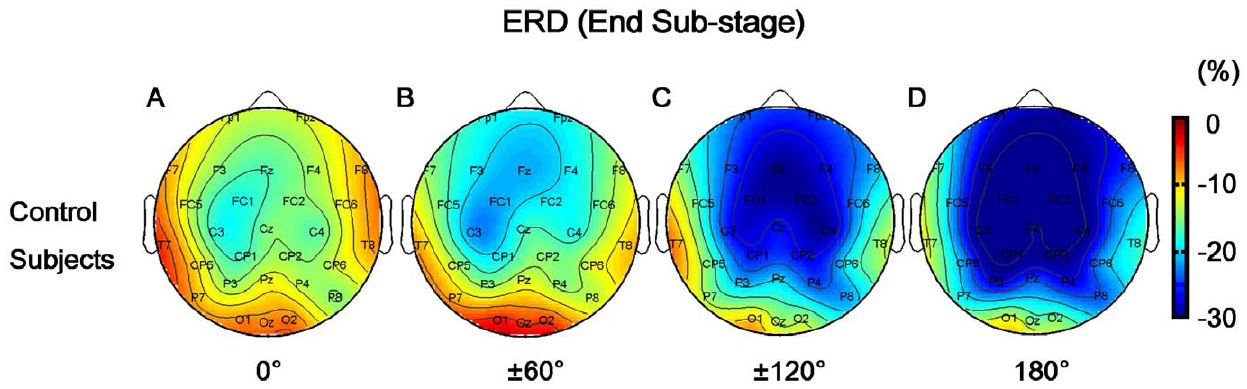
Figure 7. Brain mappings of beta-ERD for control group at different angles in response sub-stage. Higher ERD in larger brain areas particularly in right hemisphere was found with larger angles in control subjects (i.e., more brain areas with deeper blue color represented higher phase-unlocked cortical activation).